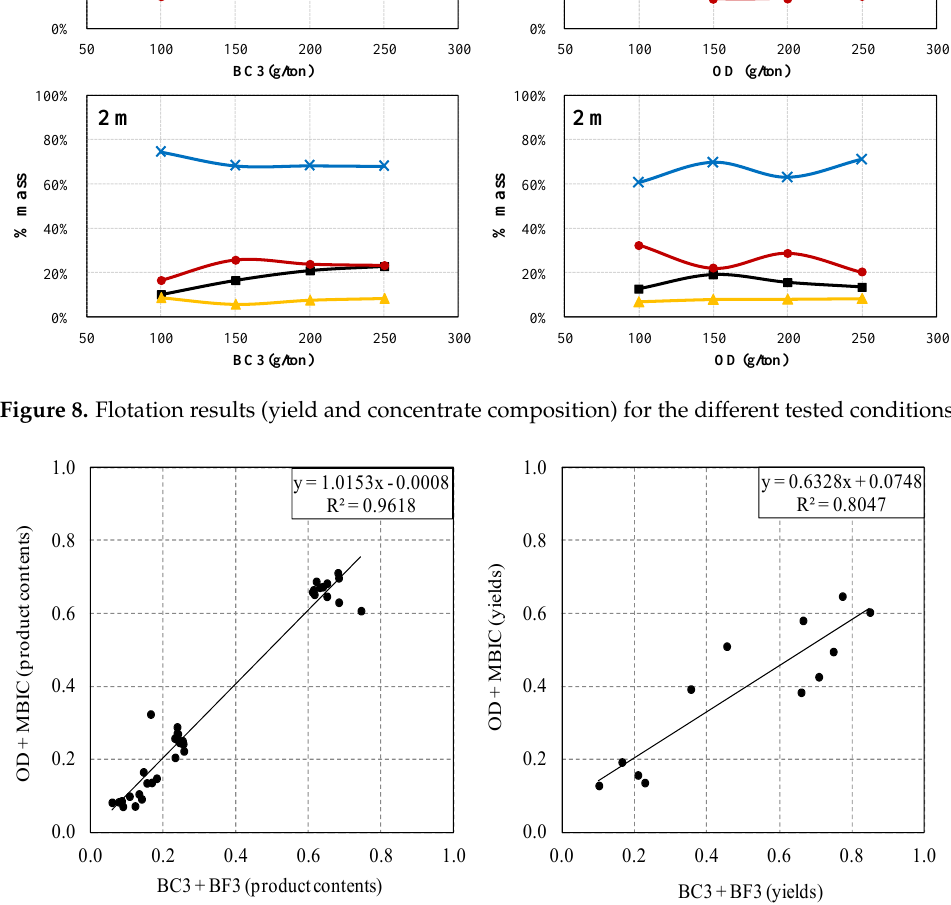
Minerals 2023 , 13 , x 10 of 14